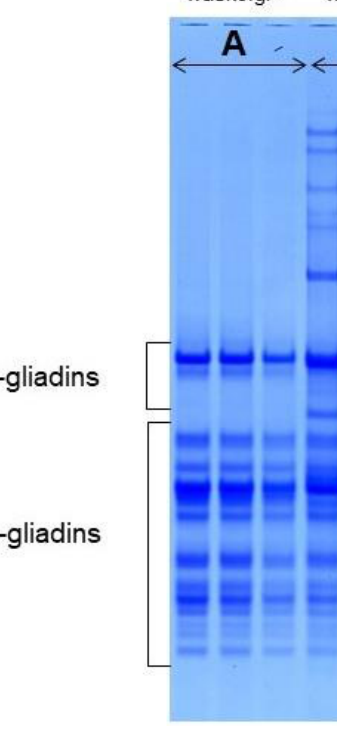
Figure 1. Comparison of gliadin proteins from: ( A ): wasko.gl − and ( B ): wasko.gl+ wheat genotypes separated by A-PAGE. Lack of all of ω -gliadin fractions in wasko.gl − wheat deficient line is clearly visible on three separations on the left-hand side of the electropherogram, part ( A ). In contrast, wasko.gl+ wheat control line contains all of ω -gliadin fractions belonging to the ω -1.2 and ω -5 subgroups (right hand side of the electrophoretic separation, part ( B ).